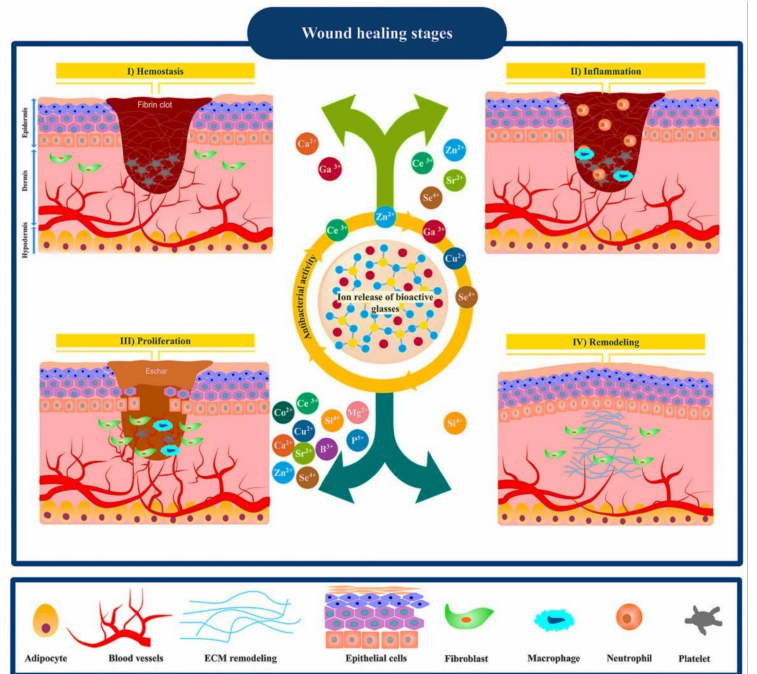
Figure 5. Schematic illustration showing four overlapping stages of the wound healing process (hemostasis, inflammation, proliferation, and remodeling) and potential effects of ionic dissolution products released from bioactive glasses (BGs) on each stage. Reproduced from [137]. Copyright 2020 American Chemical Society